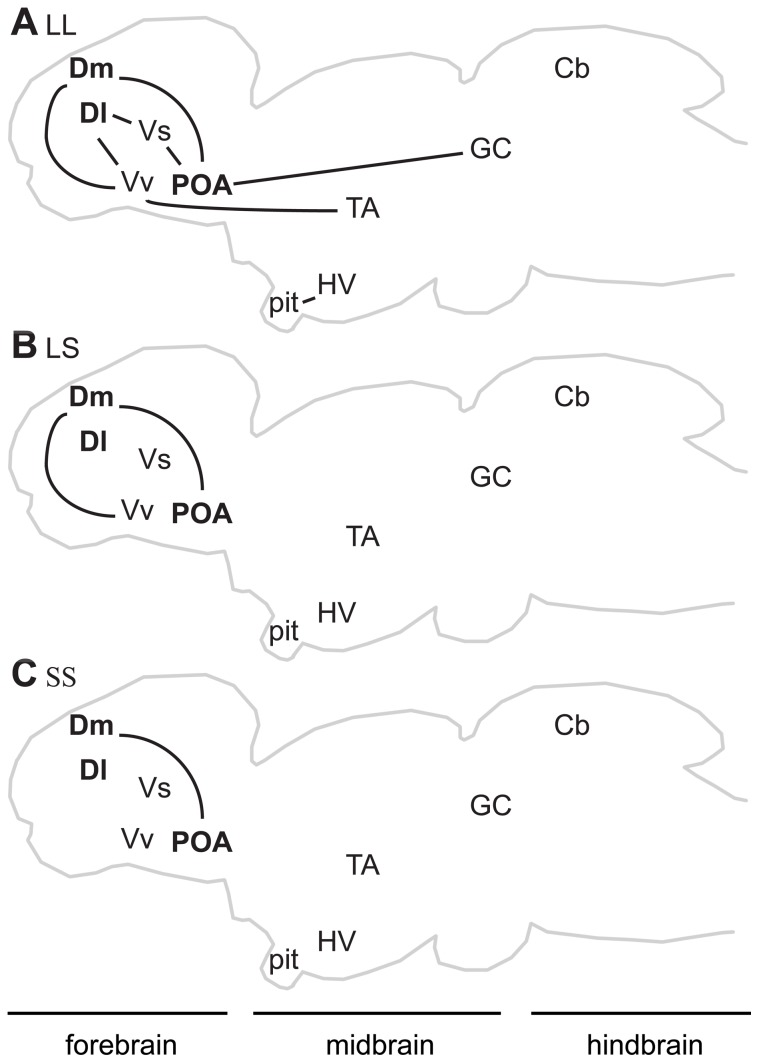

Neuroserpin expression network by context.Unique significant positive pairwise correlations relative to FF and HT females in neuroserpin expression between brain regions (lines) in A) LL, B) LS, and C) SS exposed females. Brain regions bolded in the schematic sagittal section are those associated with mate preference identified in this study.